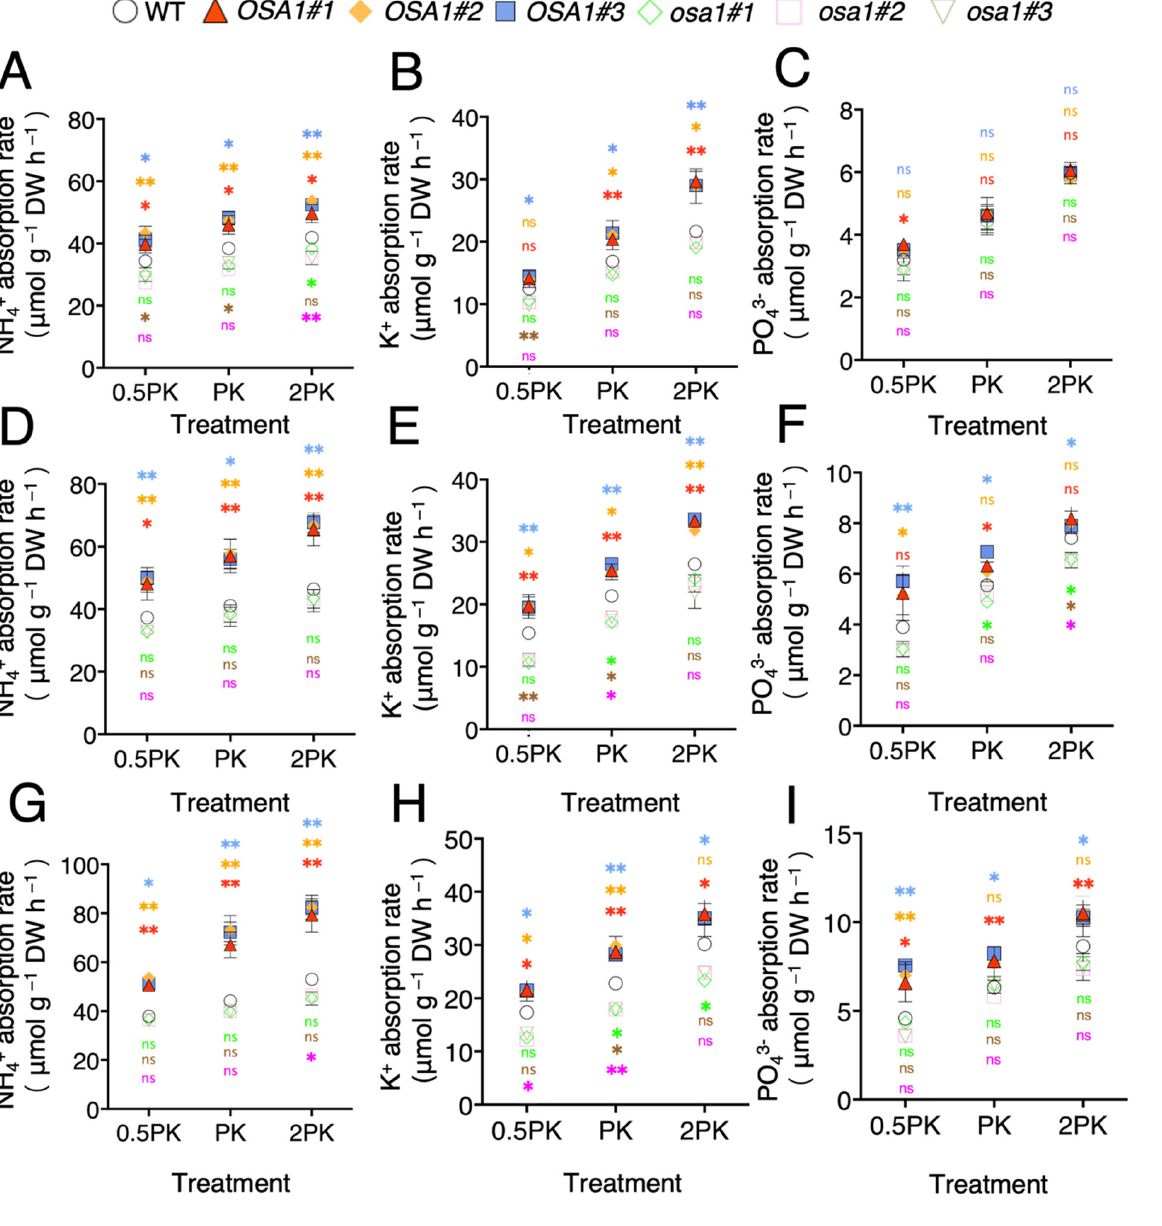
Figure 3. NH 4+ , K + and PO 43- absorption rates in roots of WT, OSA1 -oxs, and osa1 mutants. Rice plants were grown hydroponically in greenhouse for 4 weeks. Seedlings were incubated in IRRI nutrient solutions containing 2 mM NH 4+ as N source, and half (0.5PK), normal (PK), and twofold (2PK) concentrations of P and K for 1 h ( A – C ), 2 h ( D – F ), and 4 h ( G – I ). Values are the mean ± SD ( n = 3). Differences between OSA1 -oxs and WT, and between osa1 mutants and WT were assessed using the two-tailed Student’s t -test (ns, no significant difference, * p < 0.05; ** p < 0.01).